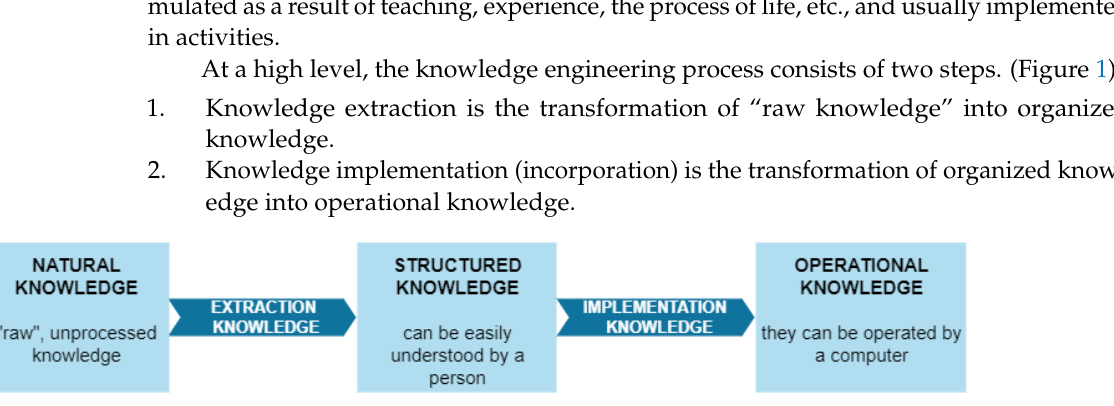
Figure 1. Process of knowledge engineering.